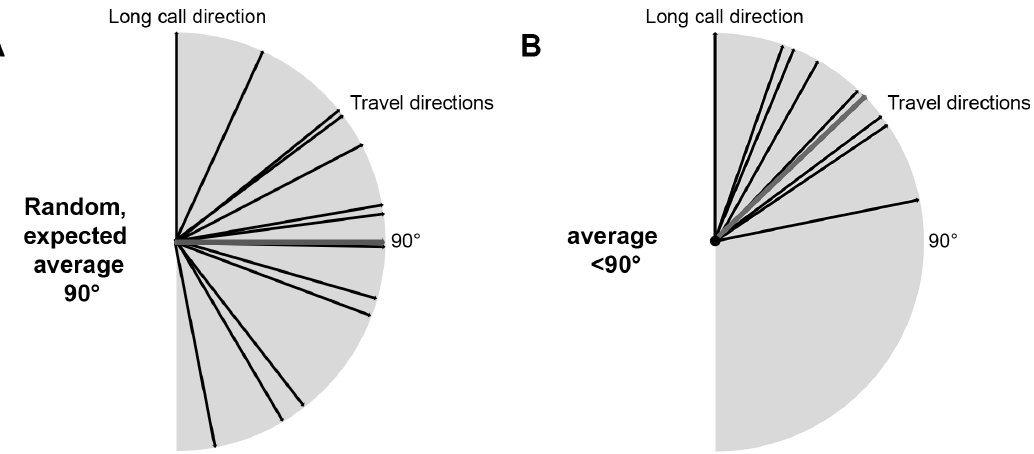
Figure 3. Relation between long call direction and subsequent travel directions. A) If travel direction and long call direction are independent of each other, we expect a uniform distribution of the deviation angles. The expected average deviation angle (in grey) would be 90 u . B)